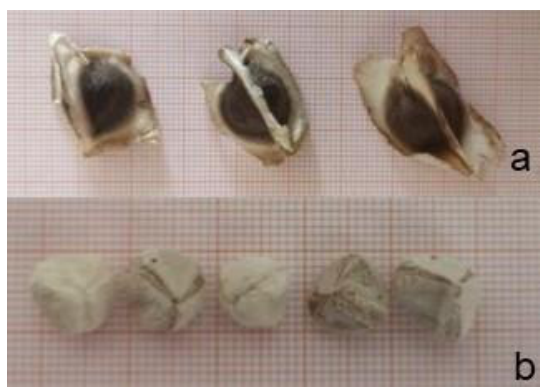
Figure 5. Moringa seeds with ( a ) and without ( b ) outer teguments.